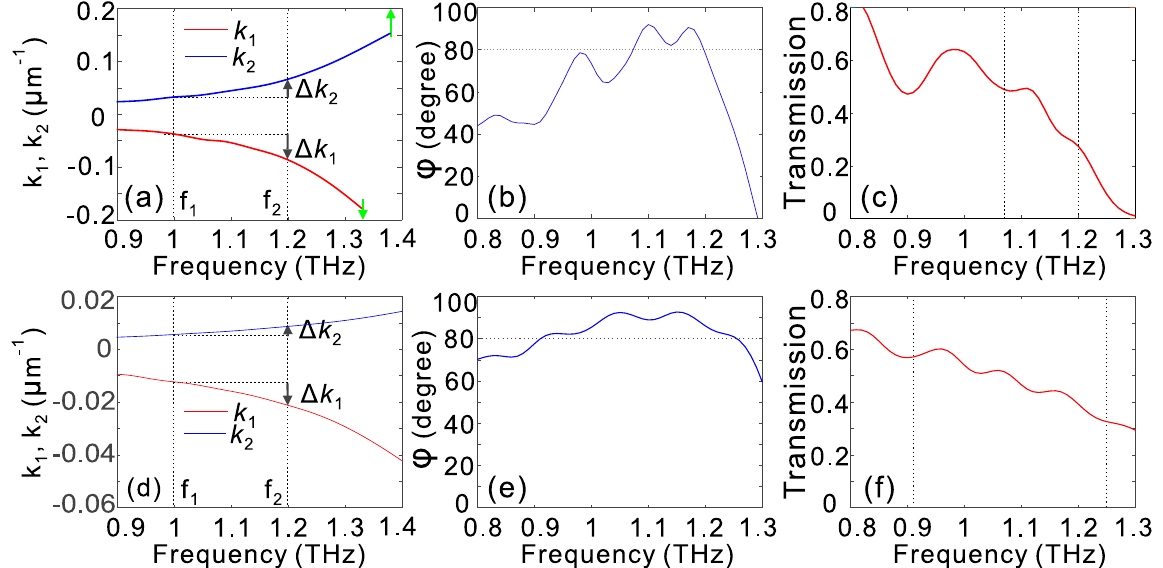
Figure 3. The performance of double-stacked HMM waveguide arrays with two cases of side dimensions. ( a , d ) k 1 and k 2 , ( b , e ) phase delay, ( c , f ) transmission as a function of light frequency with ( a – c ) H 1 = 115 μ m, H 2 = 185 μ m, L x1 = 65 μ m, L y1 = 20 μ m, L x2 = 20 μ m, L y2 = 62.5 μ m, and ( d – f ) H 1 = 400 μ m and H 2 = 1125 μ m, L x1 = 50 μ m, L y1 = 20 μ m, L x2 = 20 μ m, L y2 = 40 μ m. In ( a ), the two vertical green arrows represent the cut-off frequencies for the TE (lower HMM waveguide) and TM (upper HMM waveguide) modes, respectively. In ( d ), the cut-off frequencies for the TE and TM modes are out of the frequency range considered. The vertical dashed lines in ( c ) and ( f ) represent the phase bandwidth of operation. The lattice constants along x and y directions are p x = 80 μ m and p y = 80 μ m, and t m = 1 μ m, t d = 4 μ